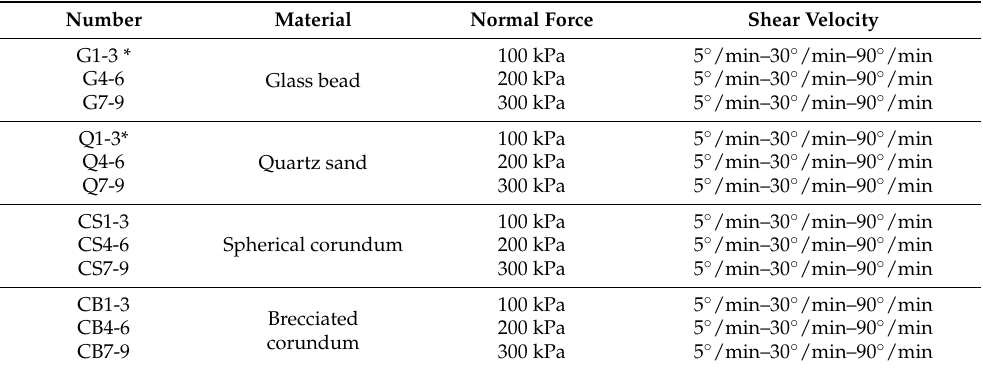
Table 1. Experimental group summary.